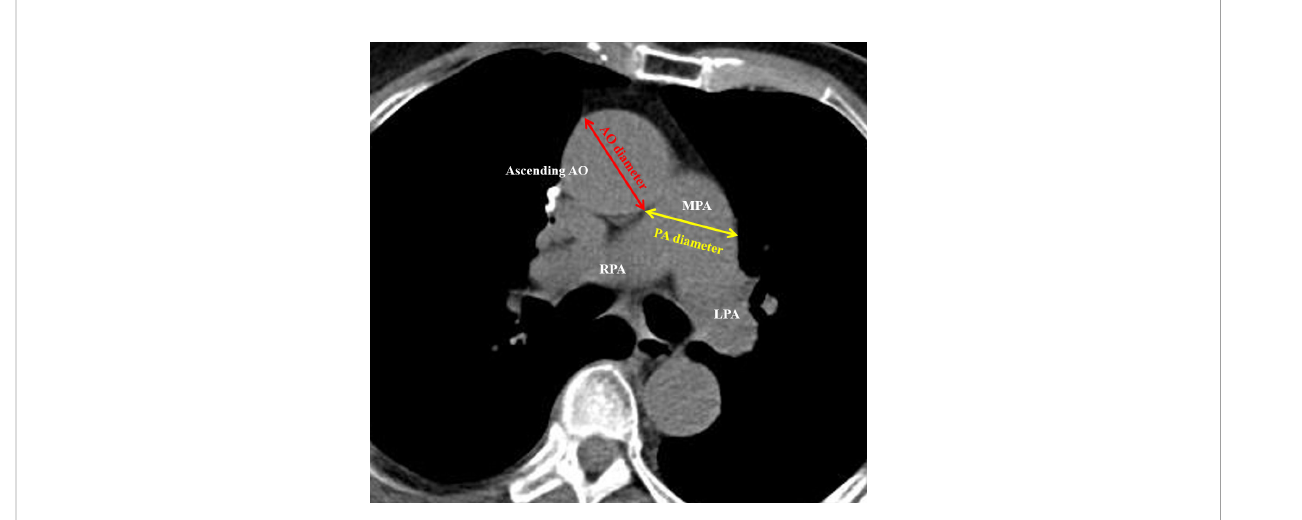
FIGURE 2 Illustration of 2D manual measurement of the pulmonary artery (PA) and aorta (Ao)